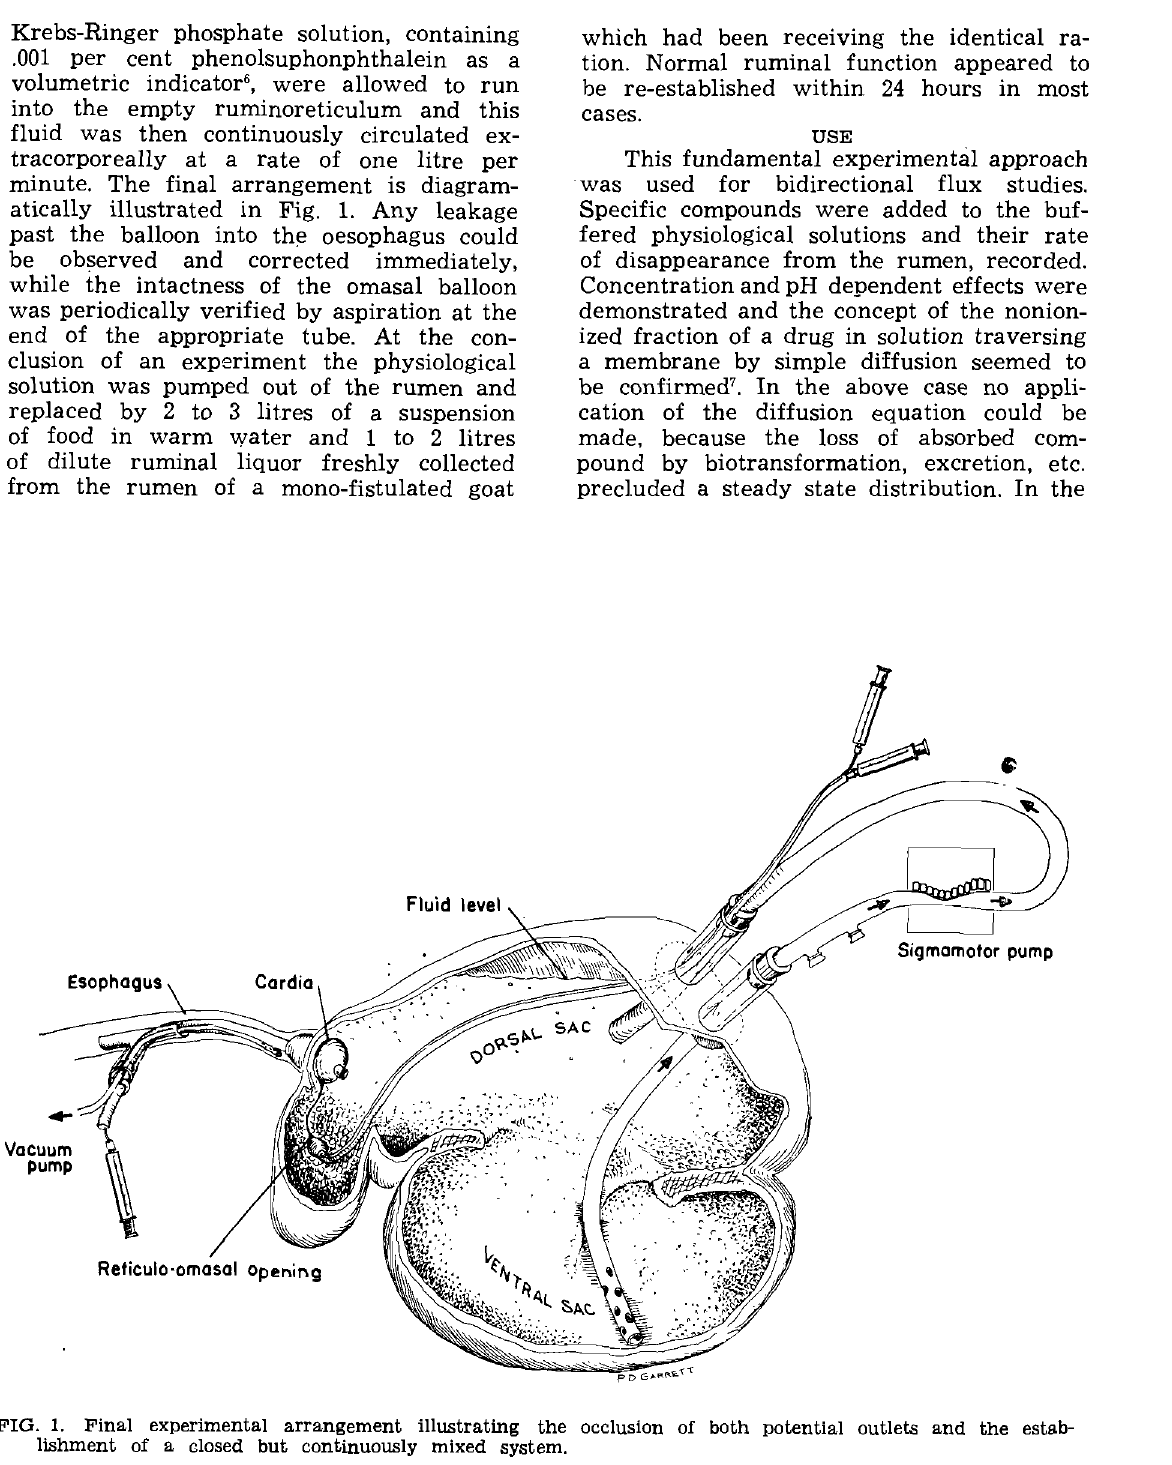
FIG. 1. Final experimental arrangement illustrating the occlusion of both potential outlets and the esta.b lishment of a closed but continuously mixed system.